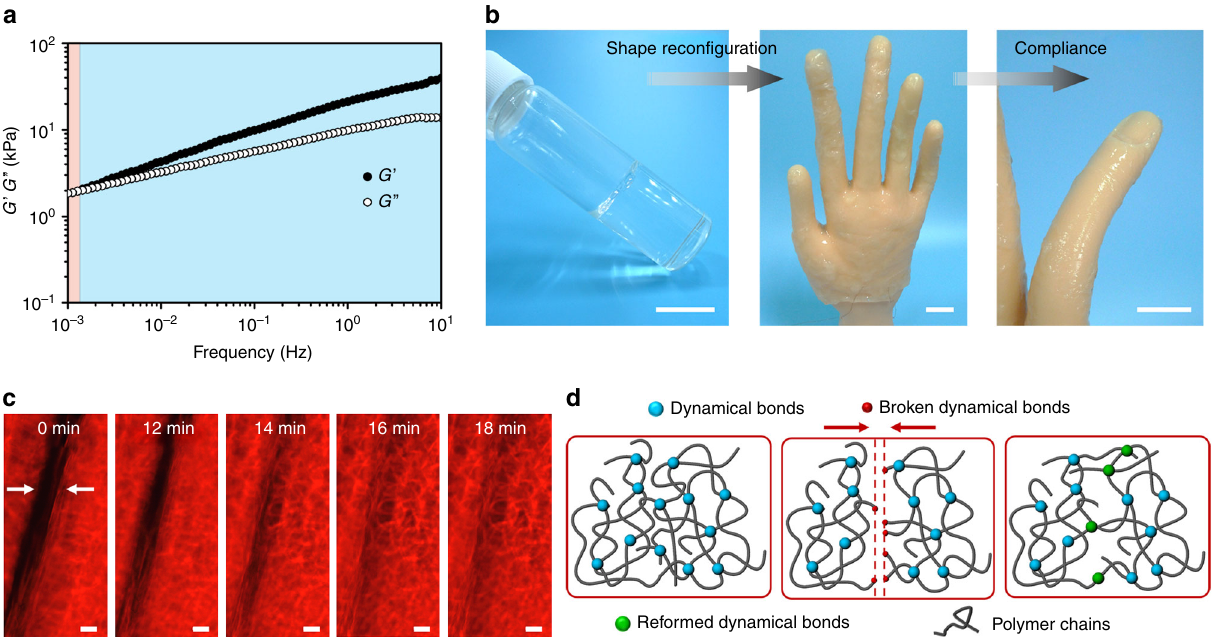
Fig. 2 Viscoelasticity, recon fi guration ability, compliance, and autonomous self-healability of the dynamic supramolecular networks. a Frequency- dependent storage ( G ’ ) and loss ( G ” ) moduli of the supramolecular polyelectrolyte hydrogel (the monomer mass ratio of AA: DMAPS is 4:1, equilibrated in 4 M NaCl). b A photo of the as-prepared transparent hydrogel; it is reshaped to adapt to the irregular surfaces of a prosthetic hand and shows compliance with the prosthetic fi nger ’ s locomotion (scale bar: 2 cm). c The direct observation of the recon fi guration and autonomous self-healing of the dynamic networks by time-resolved fl uorescence microscopic images (scale bar: 20 μ m). The white arrows indicate the chains in dynamic networks interdiffuse across the crack. d Schematic illustration of the dynamic (Fig. 1c, d) 26 , smaller swelling volume ratio (Fig. 1e, f), and higher